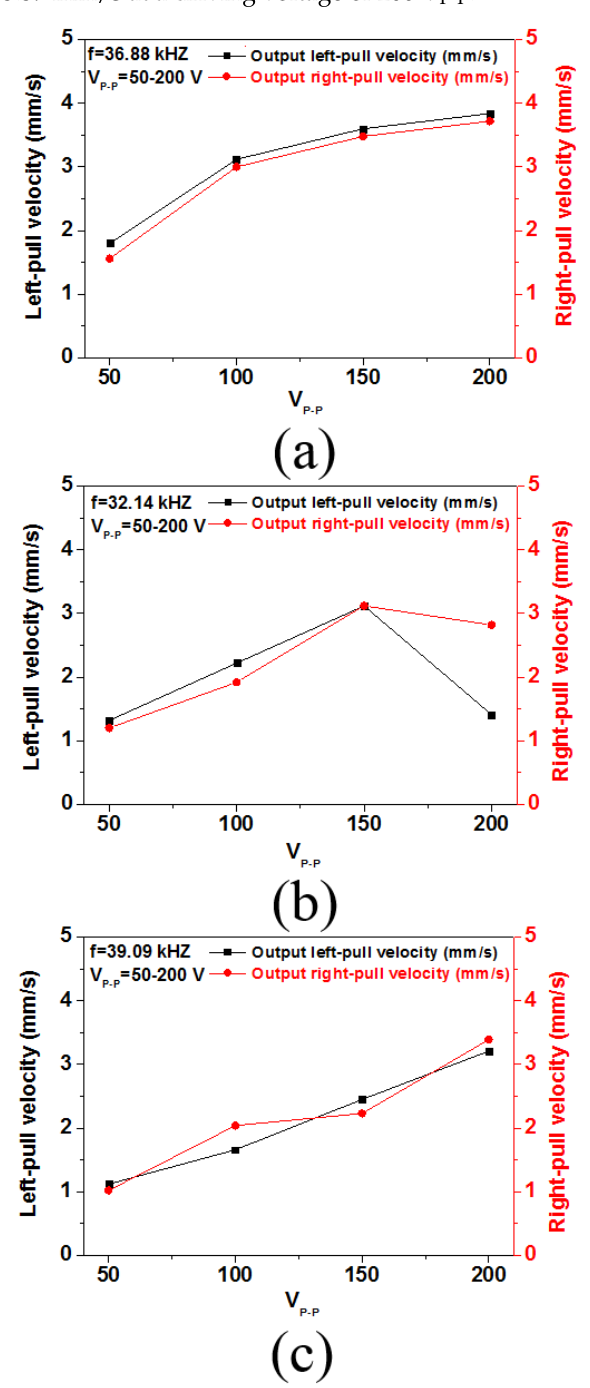
Figure 10. The relationship between the leftward and rightward speed of the ( a ) PZT, ( b ) BCTSH and ( c ) BCTSH + Mn piezoelectric motors using a two − phase driving voltage amplitude, as measured at their driving frequencies.